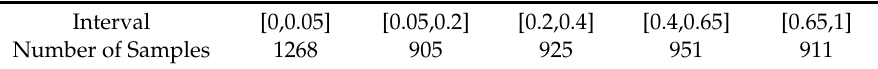
Figure 7. Point forecast and interval forecast over seven days using IMLSSVM. The cumulative distribution function graph of each model at multiple time points is made to further analyze the probability distribution of the model, as shown in Figure 8. The characteristic of the IMSPGP curve is relatively flat and the performance is general. The QRNN model has steep curve characteristics in different prediction models, indicating that it has the characteristics of sharp peaks and thin tails, and the sharpness features are obvious. As shown in sub-graph (b) and (d), when the